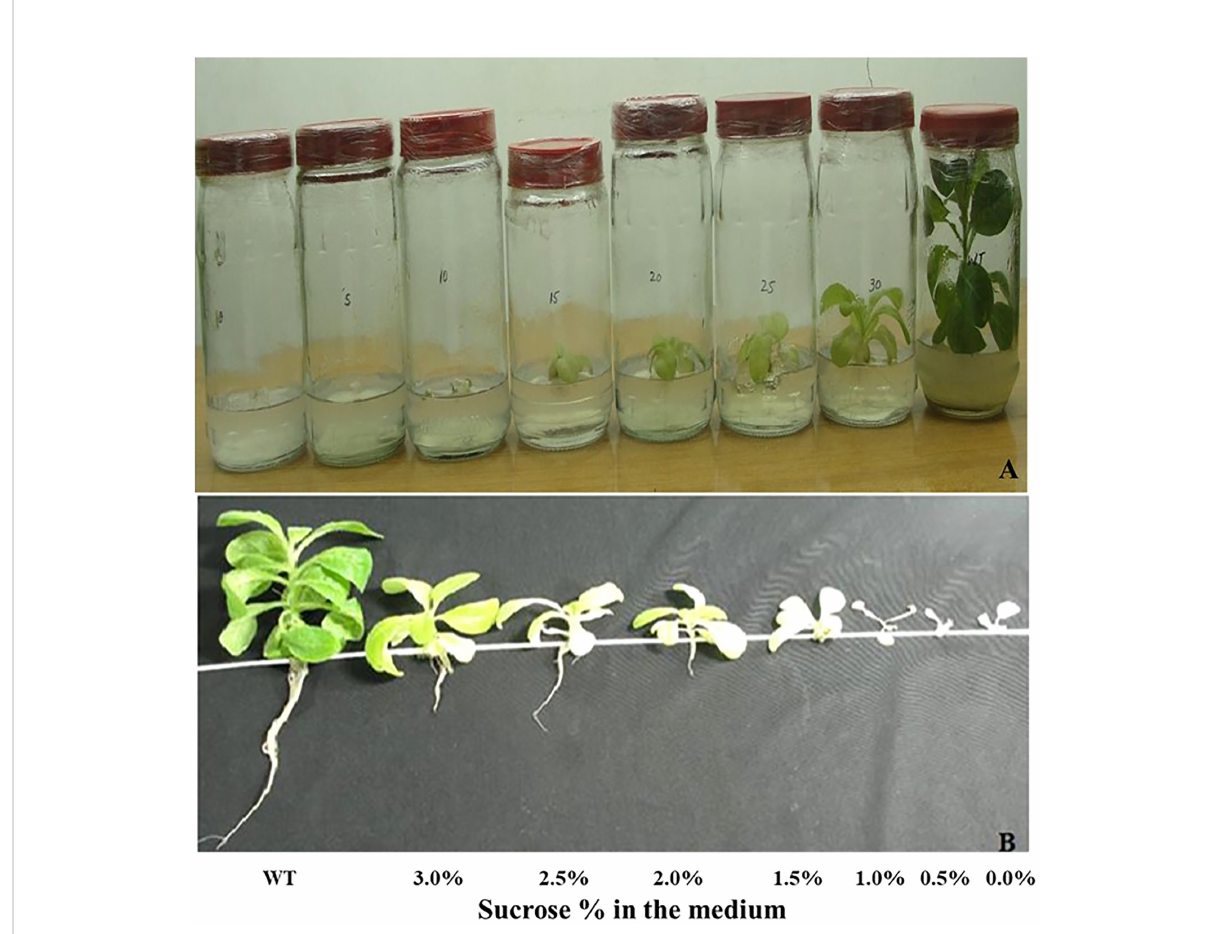
FIGURE 4 (A) Homotransplastomic D ycf4 tobacco plants were cultured on different levels of sucrose (0.0%, 0.5%, 1.0%, 1.5%, 2.0%, 2.5% and 3%) to assess autotrophic/heterotrophic nature of D ycf4 plants in comparison with wild-type in vitro growing tobacco plants. (B) Plants at A were taken out of the